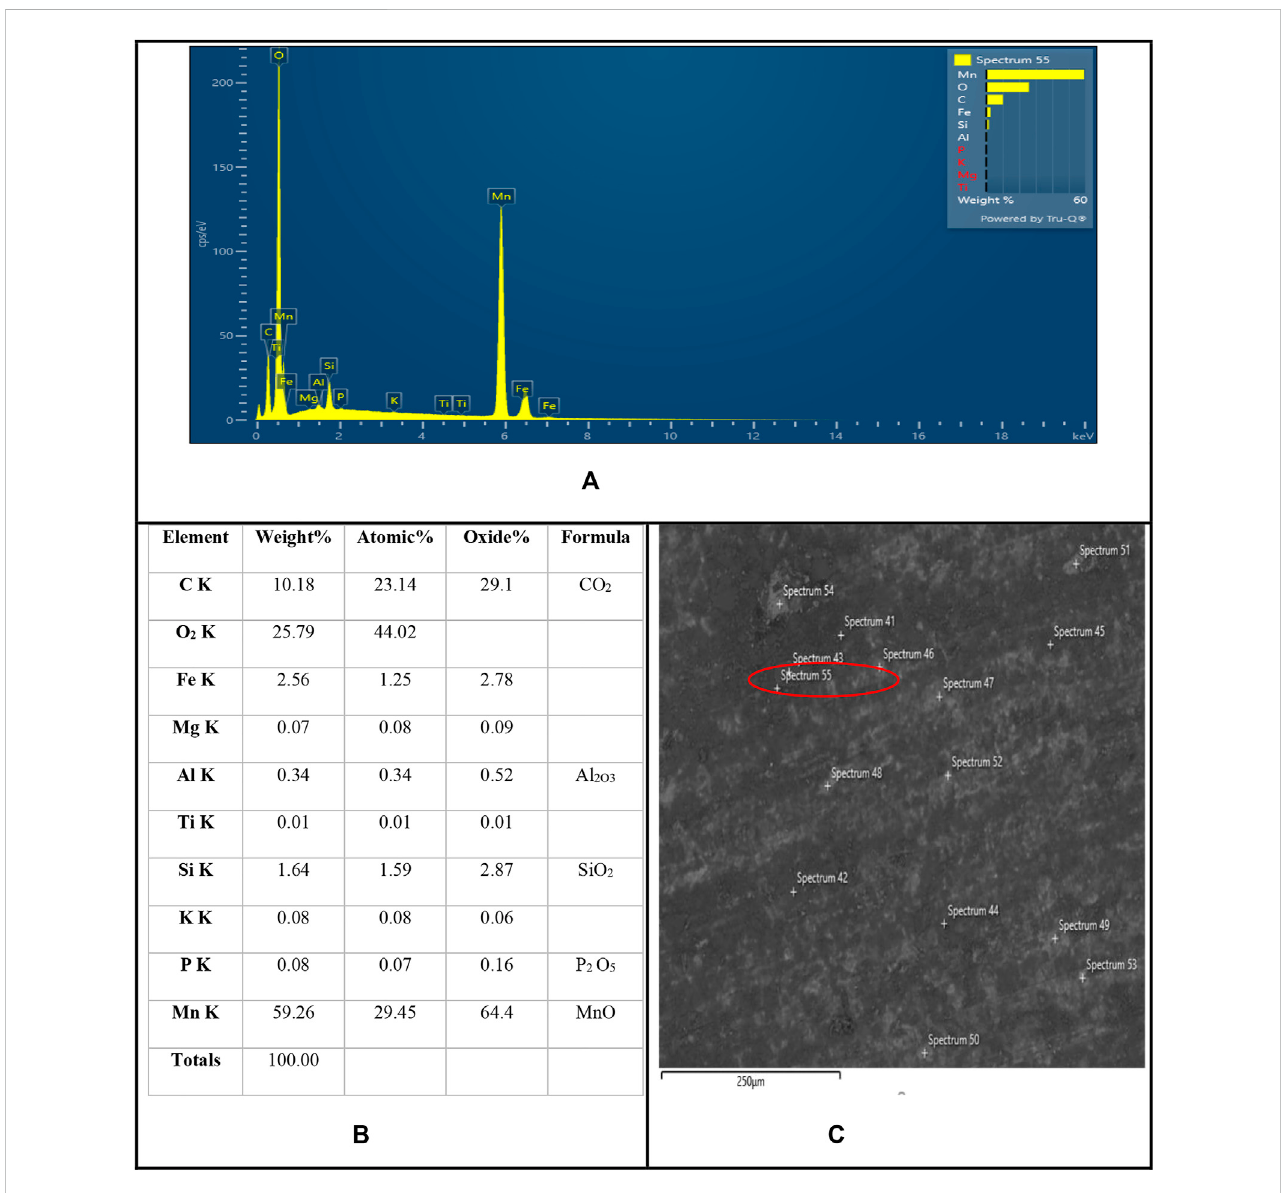
FIGURE 3 Distribution of elements after heat treatment at 525 ° C with Energy Dispersive System Analysis of X-rays using SEM. (A) . Energy dispersive X-ray (EDX) spectra of sample, (B) Table EDS analysis of inclusions from Figure (C) , (C) Complex inclusions in the sample of non-oriented electrical steel sheet containing %